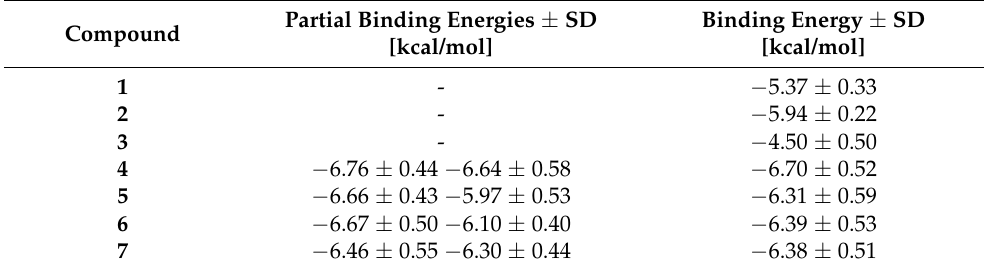
Table 5. Ligand–protein binding energies obtained as an outcome of the docking study. The numbers were averaged over the seven structures available in the PDB database; the corresponding standard deviations are given as well. The partial energies represent the values obtained for particular stereoisomers (for compounds 4 – 7 ).